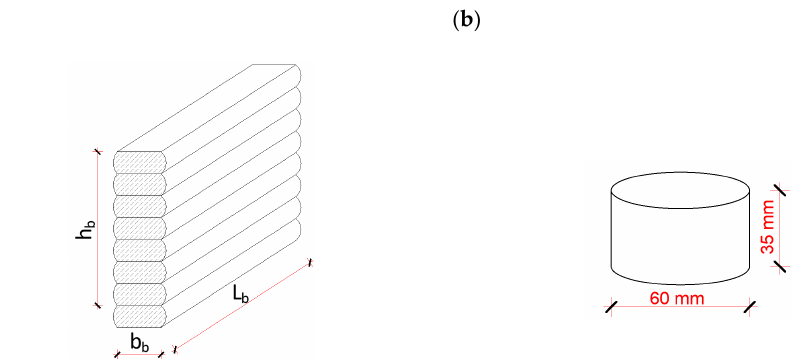
Figure 1. ( a ) scheme of analyzed wall fragment; ( b ) scheme of the specimen which was used in the squeezing test (printing simulation test).